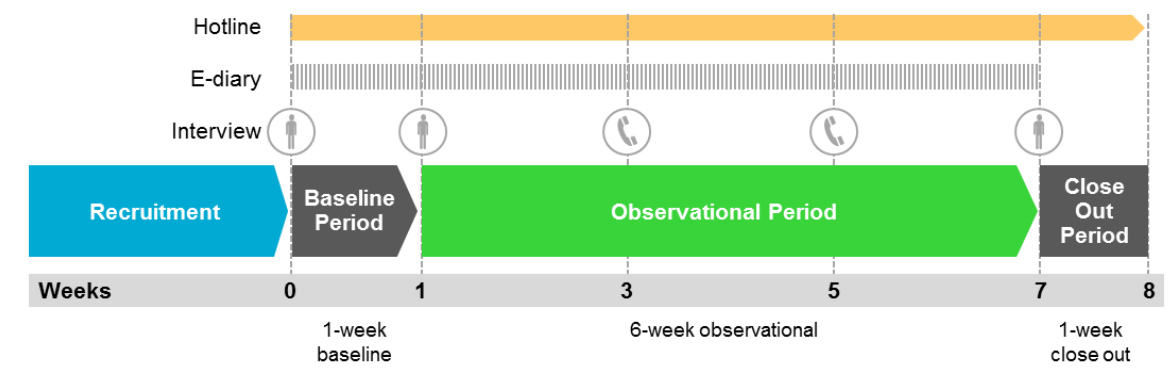
Figure 1. Scheme of study events. * During the baseline and the observational periods, participants recorded their stick-by-stick consumption of cigarettes and/or THS into an electronic diary (e-diary). Participants were able to call the toll-free telephone hotline to raise queries related to the study, resolve issues related to the e-diary or THS, and report product quality complaints and adverse health events associated with the use of